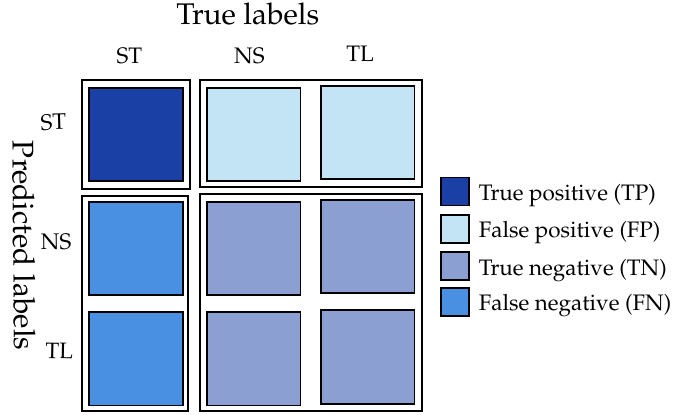
Figure 9. Confusion matrix for class ST illustrating TP ST , FP ST , TN ST and FN ST .